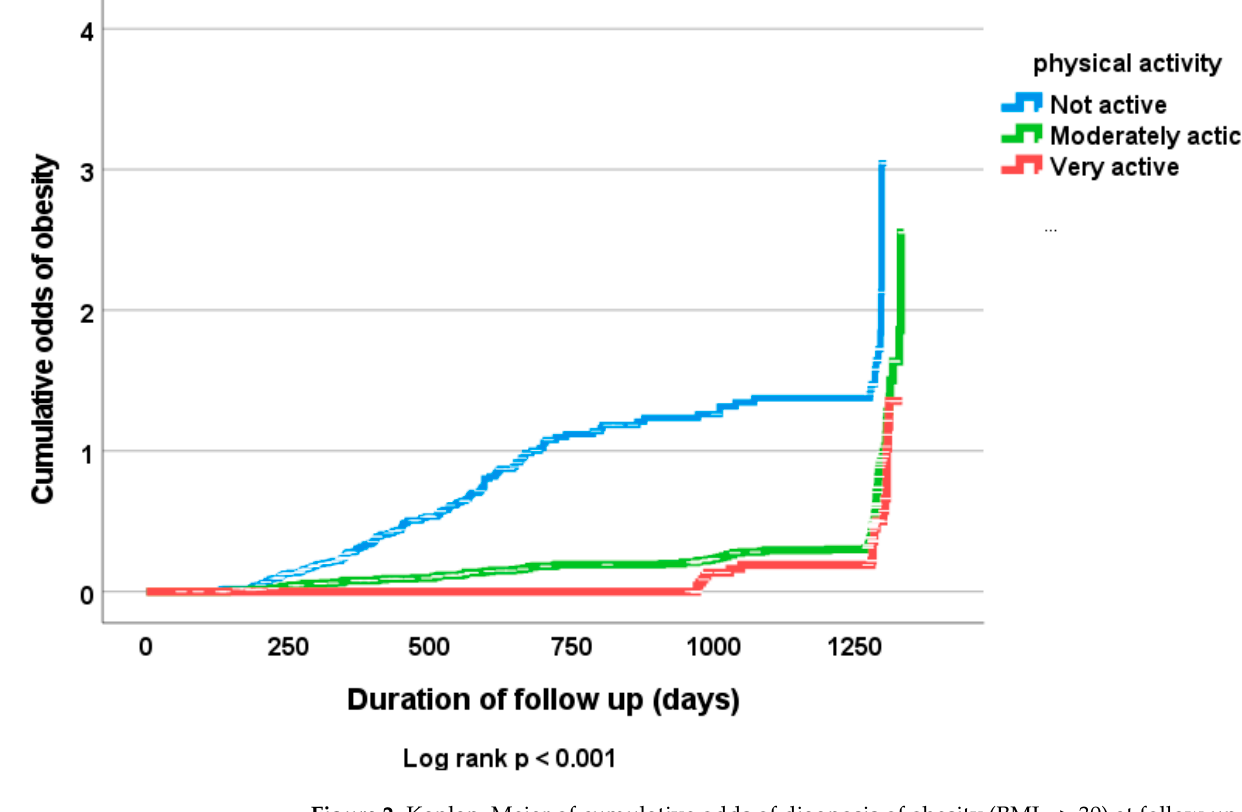
Figure 2. Kaplan–Meier of cumulative odds of diagnosis of obesity (BMI => 30) at follow up in all subjects according to levels of physical activity.